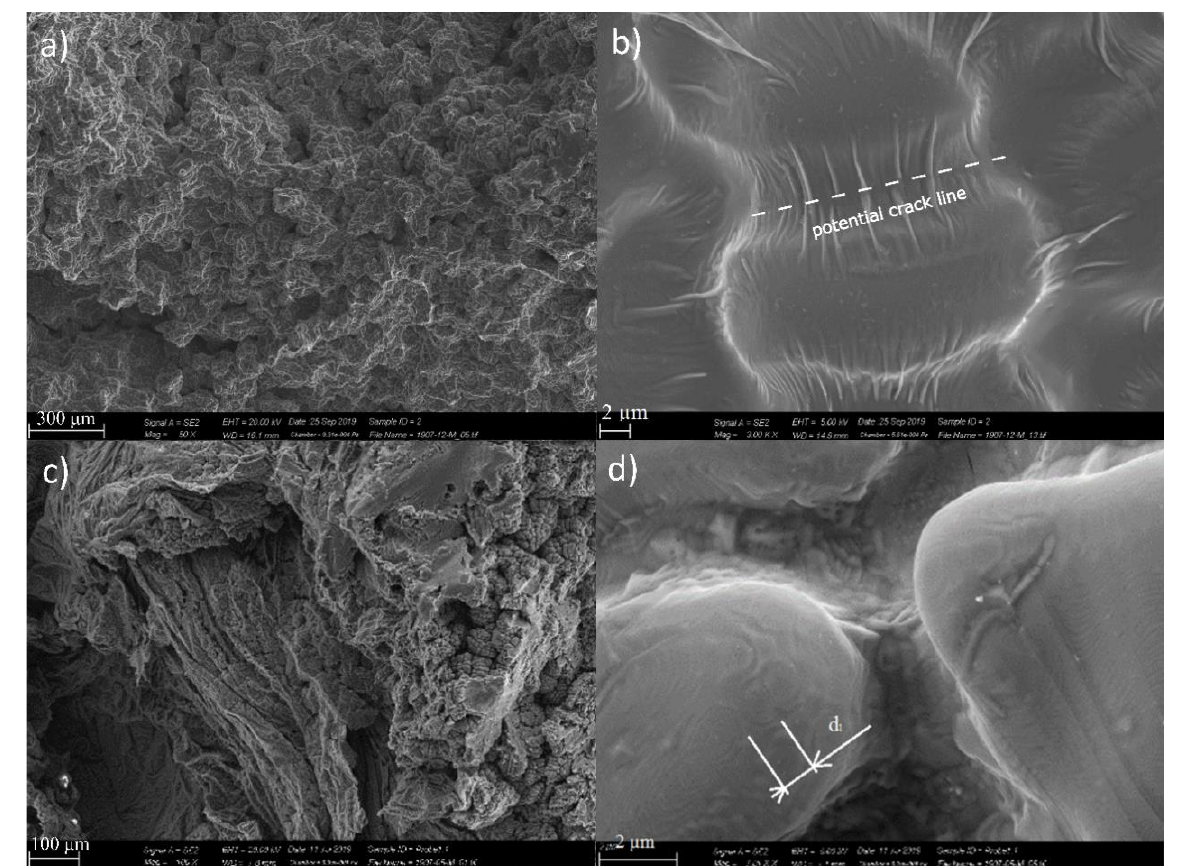
Figure 9. SEM images of the fracture surface of the AZ91 ( a , b ) and AZ91 – AlN ( c , d ) magnesium alloy. Where d l - The average size of the ring-shaped areas of deformation.